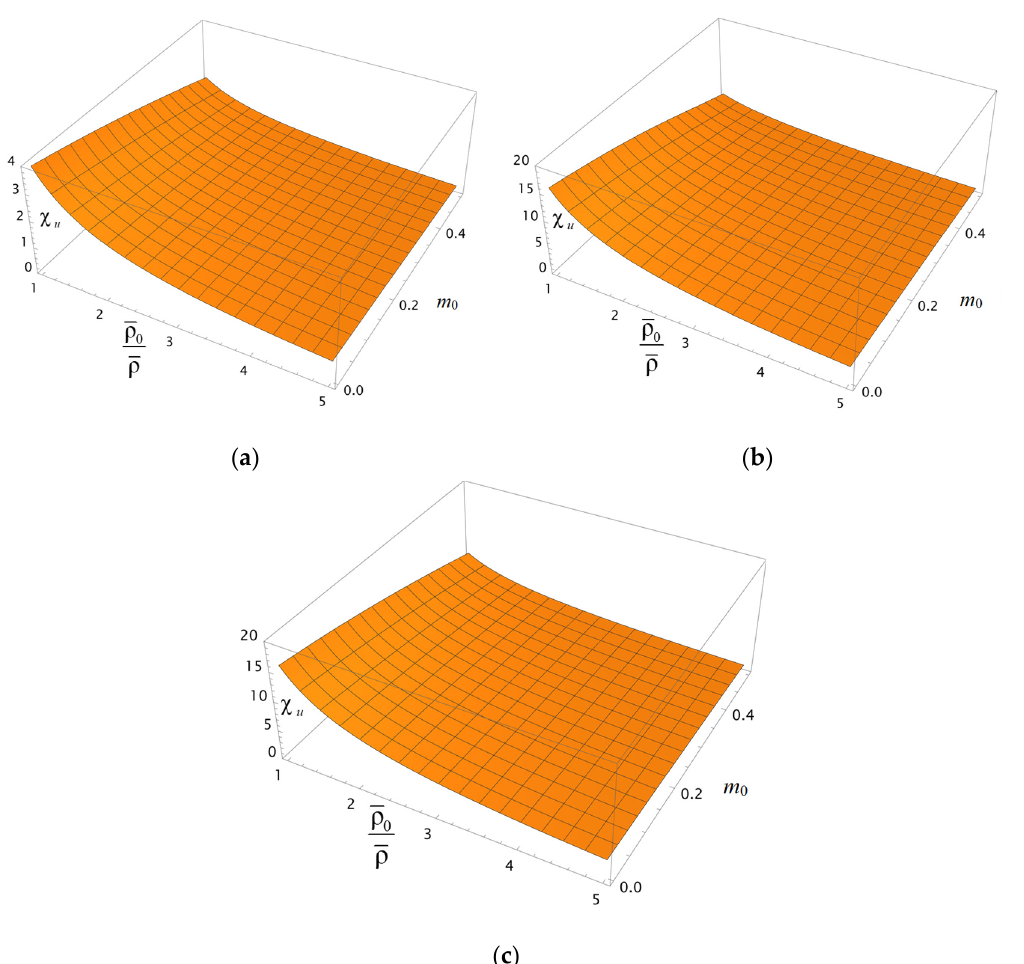
Figure 3. Dependence of the coefficient χ u on the porosity m 0 of the layer and the ratio ρ 0 / ρ of exchange capacities at s 0 = 2, C 0 / ρ = 0.1 ( a ); s 0 = 4, C 0 / ρ = 0.1 ( b ); s 0 = 4, C 0 / ρ = 0.5 ( c ); D + / D m + =